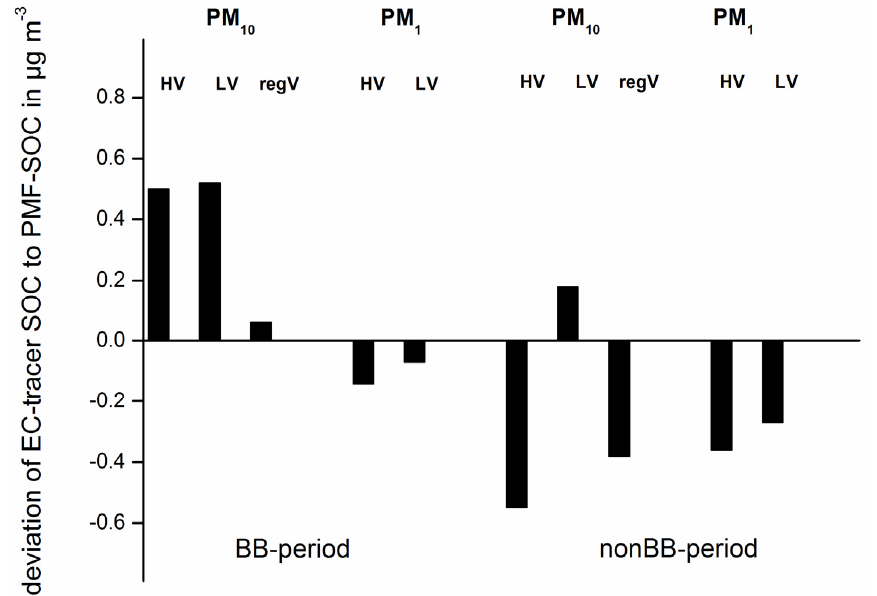
Figure 3. Deviation between EC-tracer and PMF